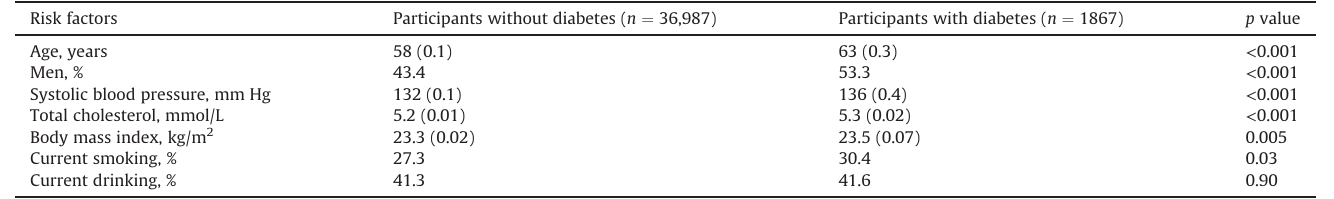
Table 2 Baseline characteristics of the study sample by diabetic status. Risk factors